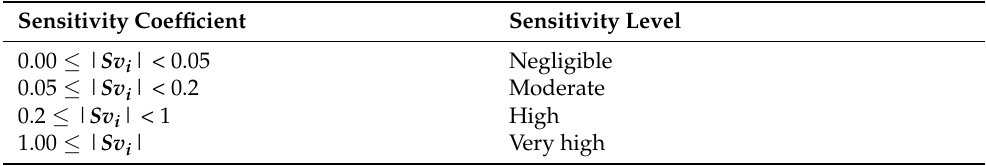
Table 1. Classification of the sensitivity